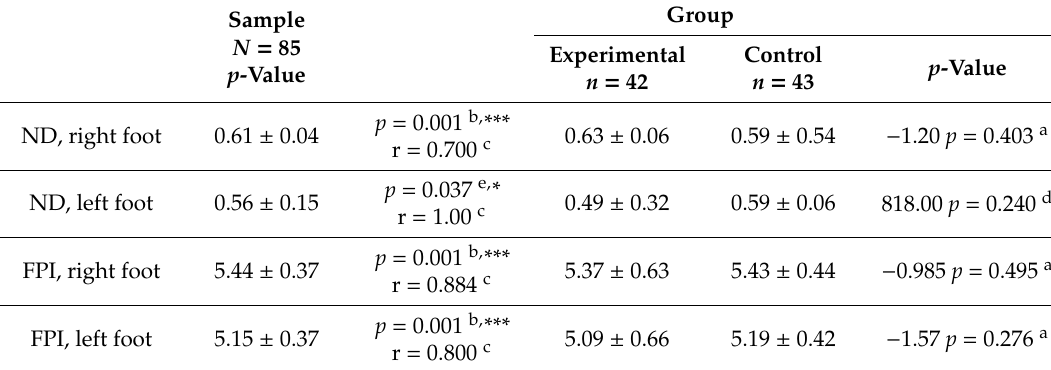
Table 2. Descriptive statistical analysis after the training period of four weeks for the total sample and both groups.